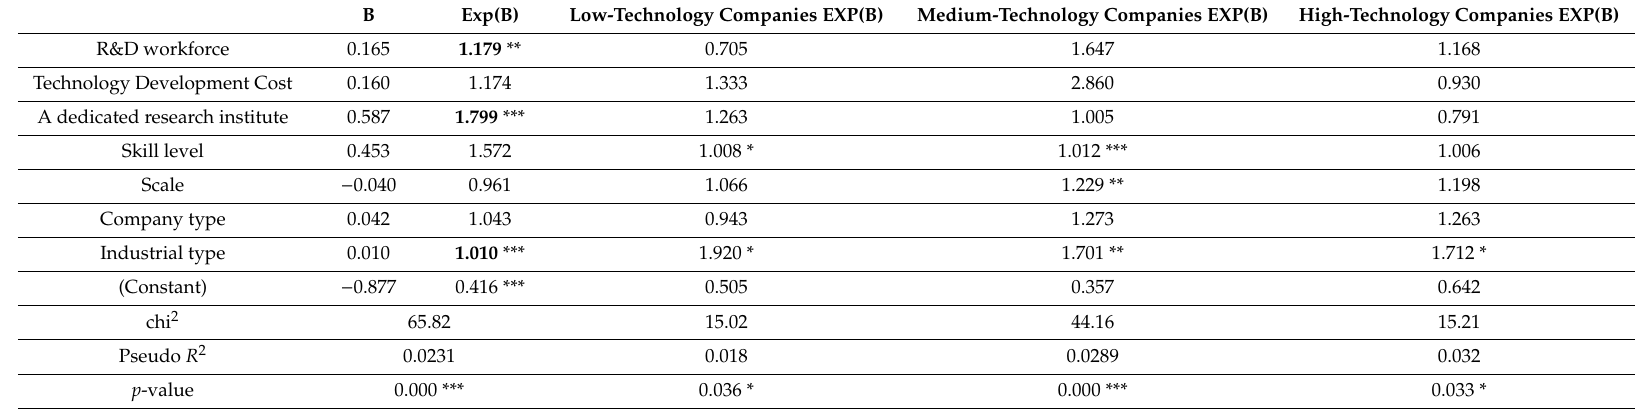
Table 5. Logistic analysis result on product competitiveness of technology development